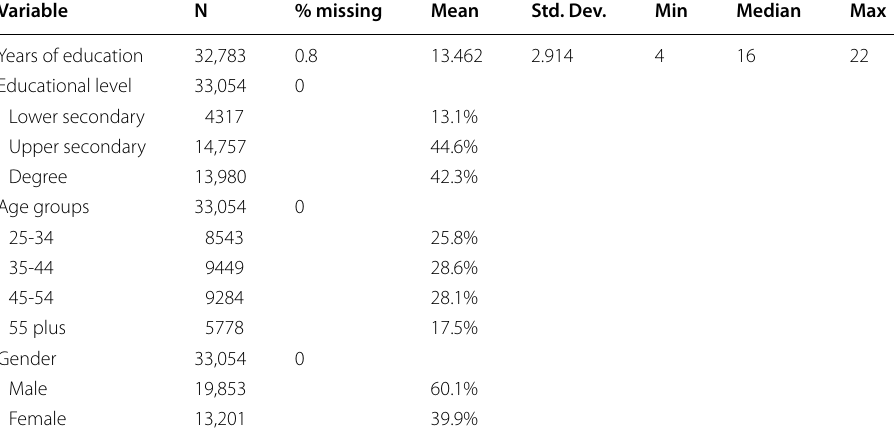
Table 2 Summary statistics for covariates. Source: PIAAC 2012 Variable